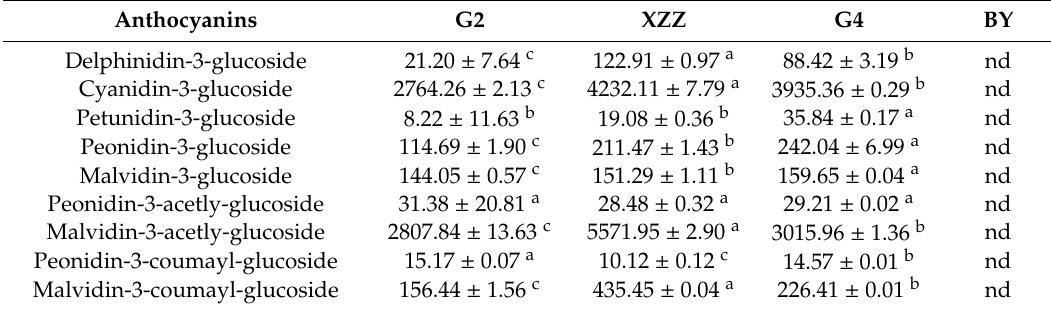
Table 2. Anthocyanin profiles of Chinese wild spine grapes (mg /